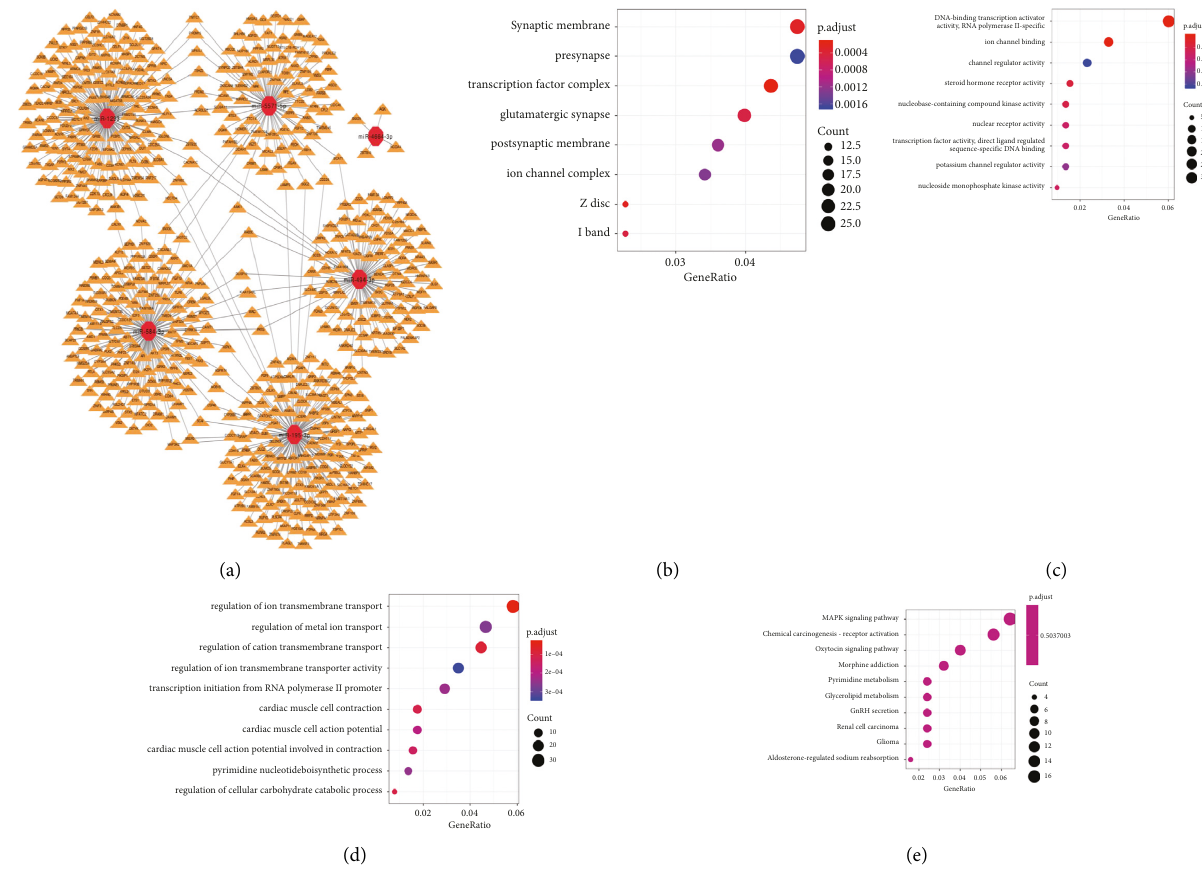
Figure 11: Potential connection between miRNA and target gene was visualized by Cytoscape and enrichment analysis of six target genes. (a) Visualization of six microRNA target genes; (b–d) GO enrichment of target genes (b) CC, (c) BP, (d) MF; (e) KEGG enrichment of target